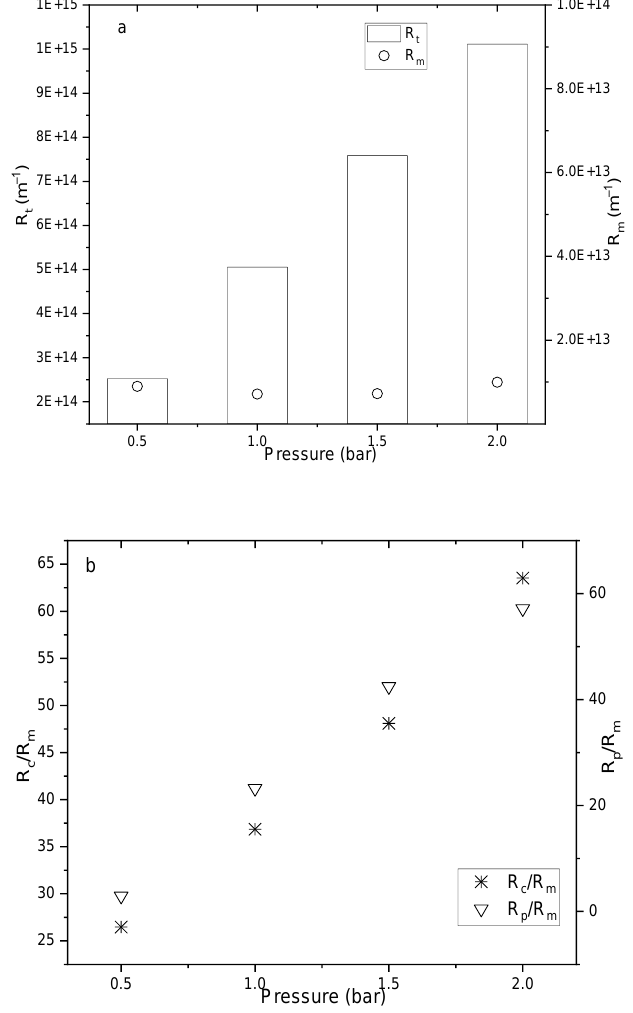
Figure 6. Derived membrane resistances for the frontal (dead-end) filtration experiments. ( a ) Total filtration resistance R t and intrinsic membrane resistance R m versus applied pressure; ( b ) normalised cake filtration resistance as the ratio R c / R m , and pore resistance R p / R m versus applied pressure. The initial applied pressure is essential for R c (as discussed in Section 3.2.1). R t , R c and R p were all increased with increased applied pressure. There was a positive correlation between pressure and resistances ( R t R 2 ≥ 0.99, R c R 2 ≥ 0.99, and R p R 2 ≥ 0.99). At a pressure of 2 bar, the R p accounted for 47% relative to the total resistance, increasing by 95% from 0.5 bar to 2 bar. However, even though the increased rate of R p was larger than that of R c , the R c / R t value (52%) was slightly higher than R p / R t . This suggested that